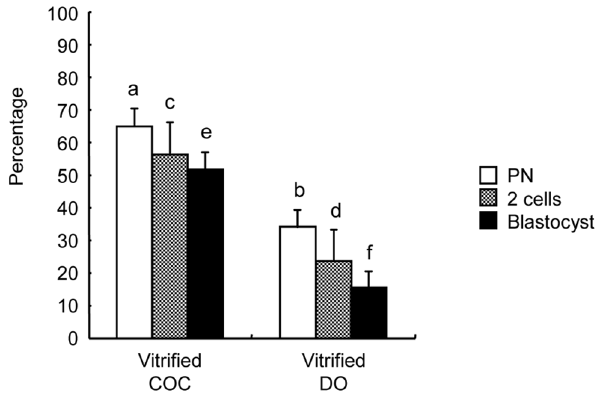
Fig. 2. The effects of cumulus cells on the fertility and developmental ability of vitrified C57BL/6J mouse oocytes after IVF. IVF was carried out using frozen-thawed BDF1 mouse sperm. Data are means 6 S.E.M. a-b,c-d,e-f Different superscripts denote significant difference ( P , 0.05). In each treatment group, more than 100 oocytes were examined.